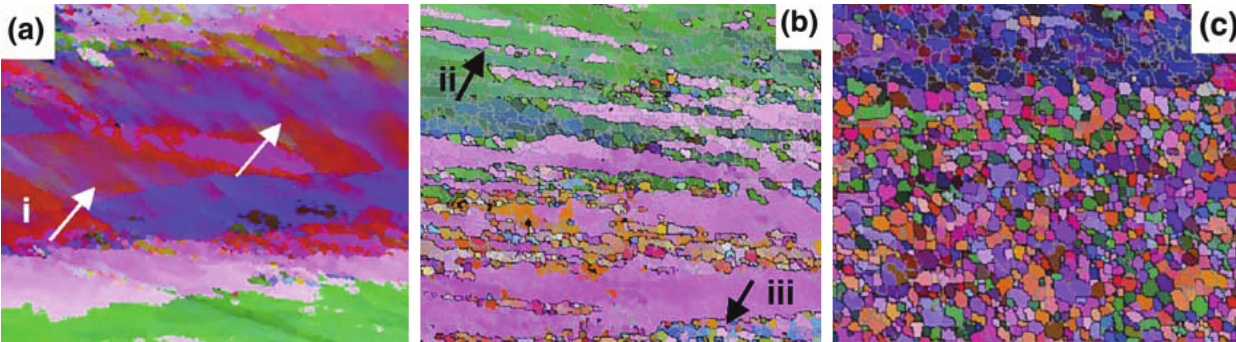
Figure 3 . Electron backscatter diffraction (EBSD) maps showing the development of grain structures in different zones associated with the strain and temperature change in friction stir processing (after Prangnell and Heason [57]): (a) materials far away from the tool pin showing split grains into deformation bands; (b) materials close to the tool pin showing parallel bands separated by fine grains; (c) very fine nugget grains in the material immediately next to the tool pin